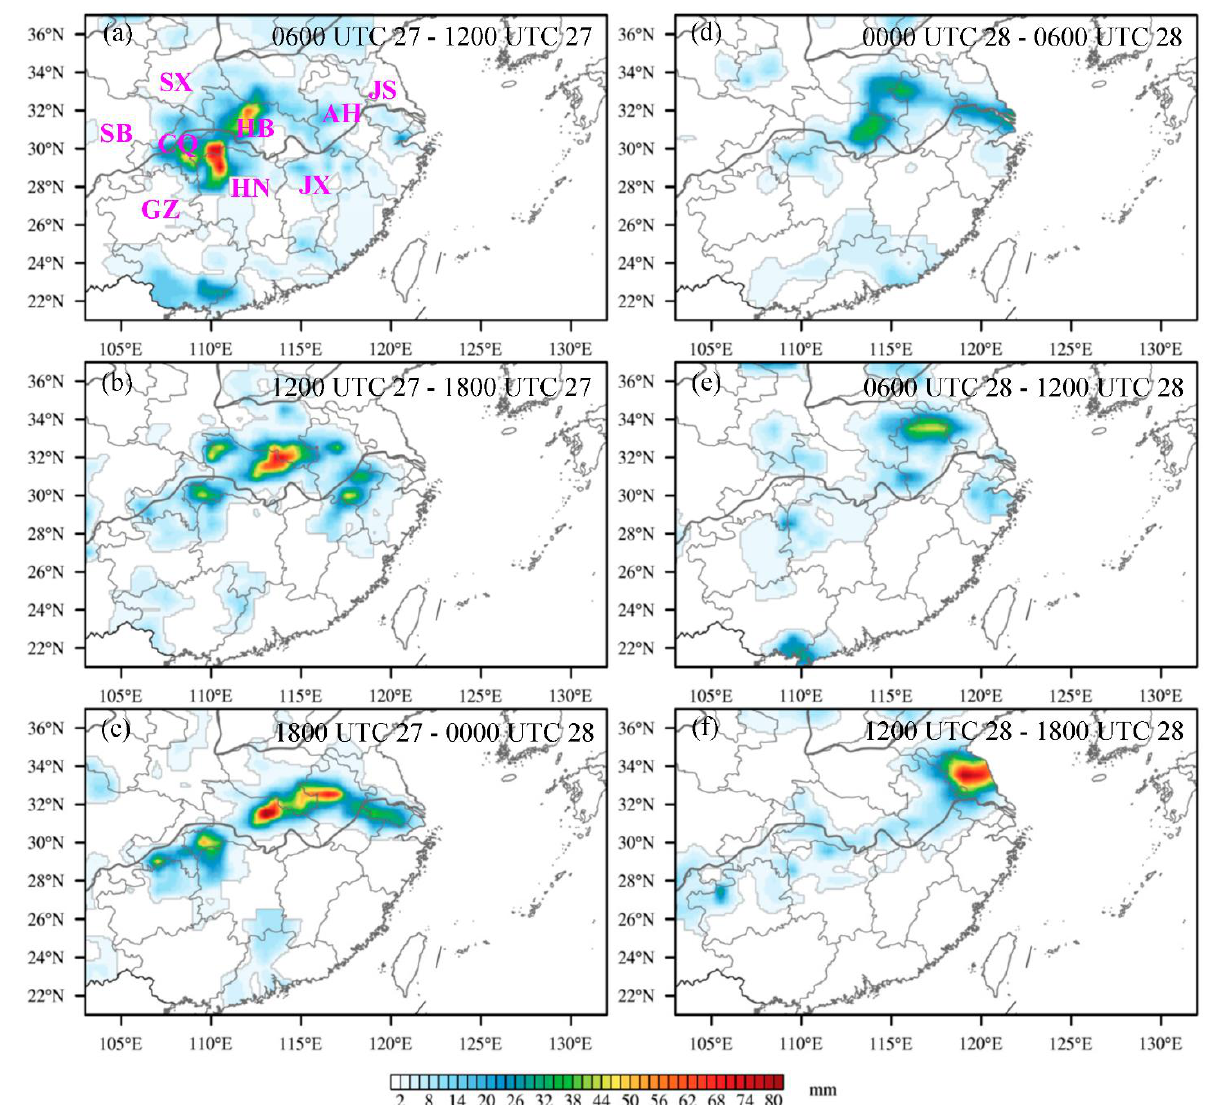
Figure 2. Observed 6-h accumulated precipitation (shading, units: mm). SB = Sichuan Basin, SX = Shanxi Province, CQ = Chongqing, GZ = Guizhou Province, HB = Hubei Province, HN = Hunan Province, JX = Jiangxi Province, AH = Anhui Province, JS = Jiangsu Province.